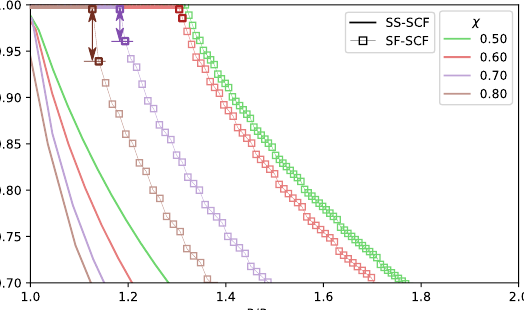
Figure 9. Local polymer density in the center of a pore φ ( z = R ) as a function of normalised pore radius R / N for selected values of χ -parameter ( 0.3,0.4,0.5,0.6,0.7,0.8 ) . The value of χ are color coded, and the results calculated by numerical SF-SCF method ( φ SF ( z = R )) are presented as squared markers while solid lines trace the values of ( φ SS ( z = R )) calculated analytically. N = 1000, σ = 0.02.